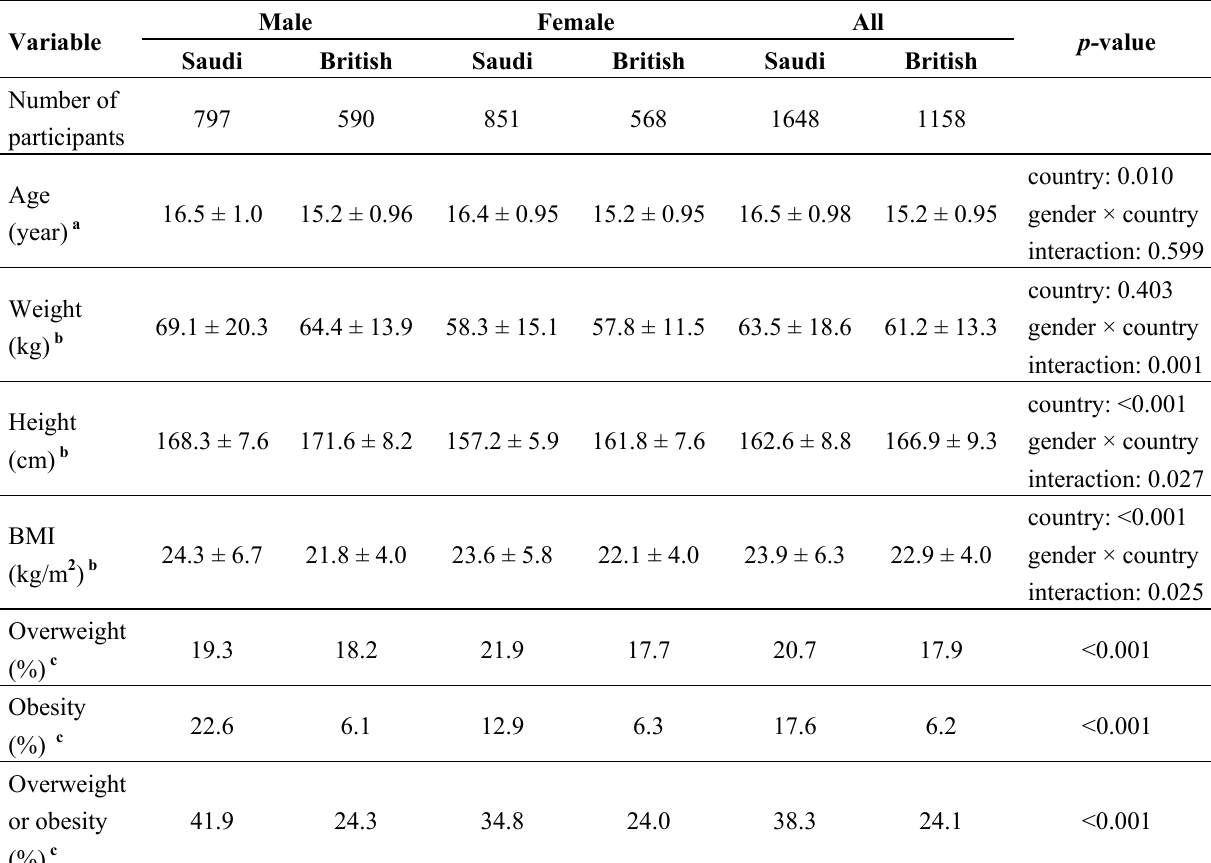
Table 1. Anthropometric characteristics of Saudi and British